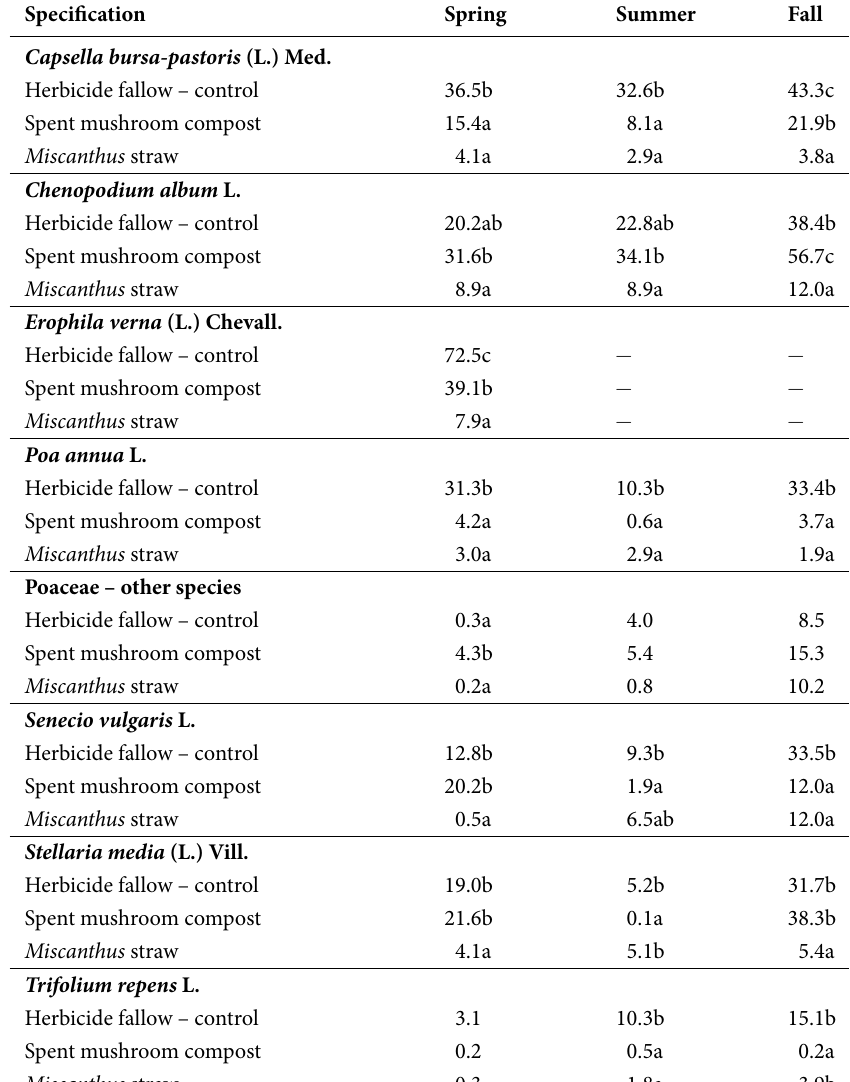
Table 4 Comparison of the three orchard floor managements with respect to the mean percentage of soil surface under coverage the most important weeds in tree rows in different seasons, mean for the years